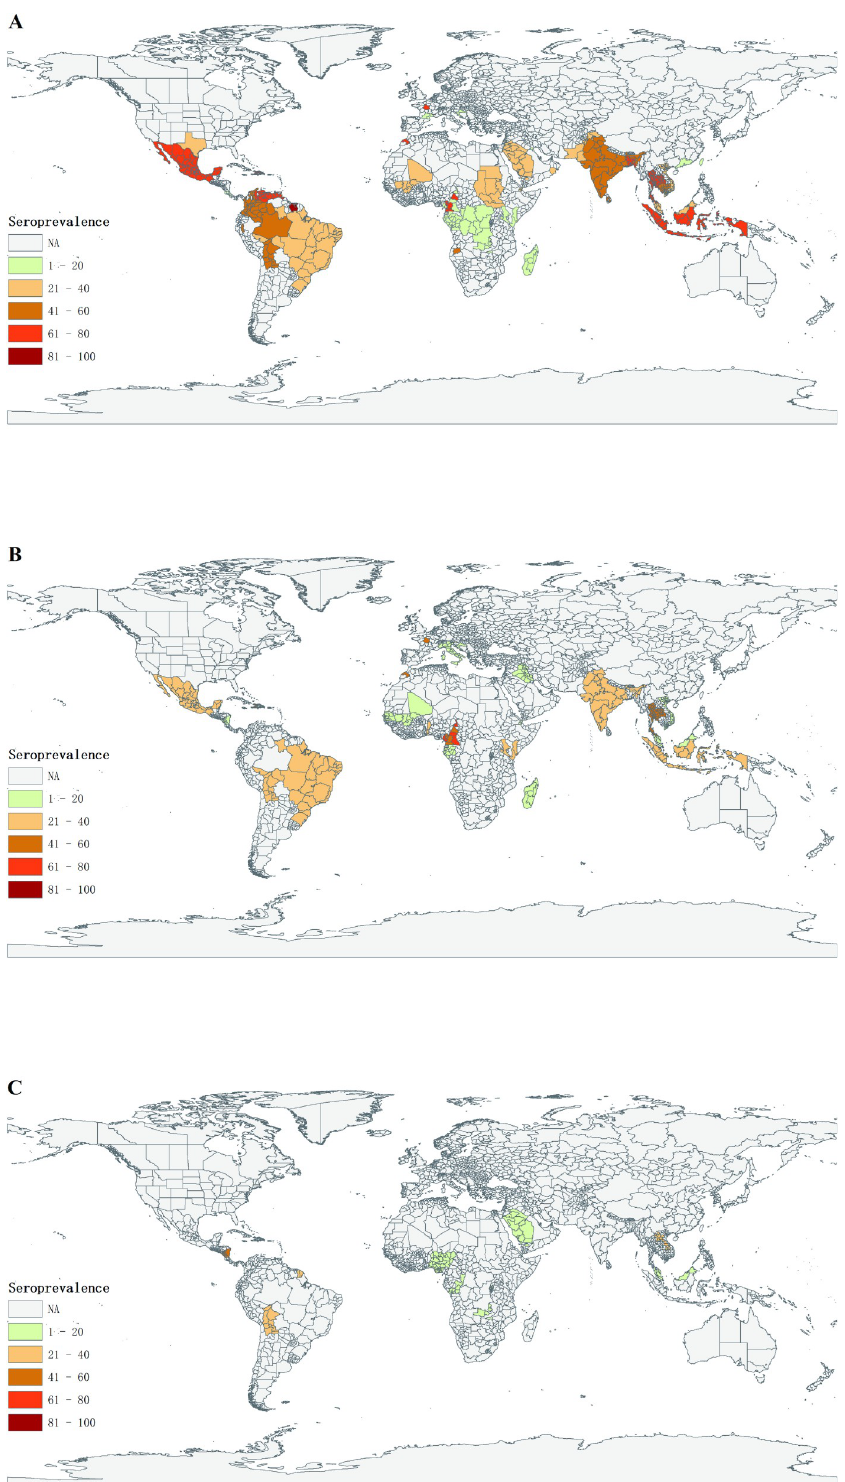
Fig 2. Graphical presentation of seroprevalence across the world for DENV(A), CHIKV(B) and ZIKV (C) infection. The map was drawn by ArcGIS program (version 10.4.1; ESRI, Redlands, California, USA) using the base layer ( https://pro.arcgis.com/zh-cn/pro-app/latest/help/mapping/properties/plate-carree.htm).